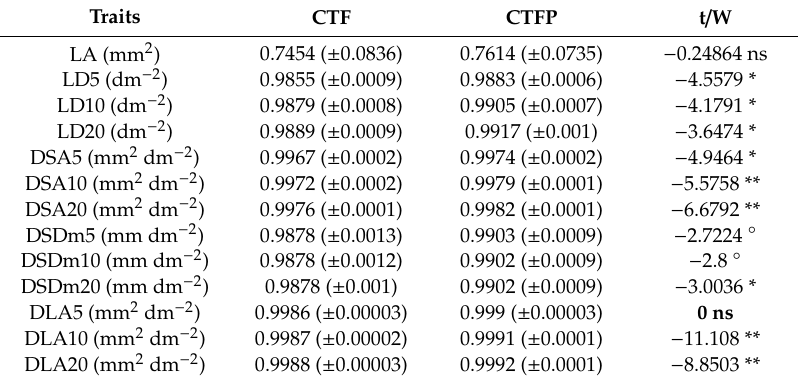
Table 3. Summary of the functional diversity variance FDvar for both multi-specific communities and results from the T and Mann-Whitney tests.